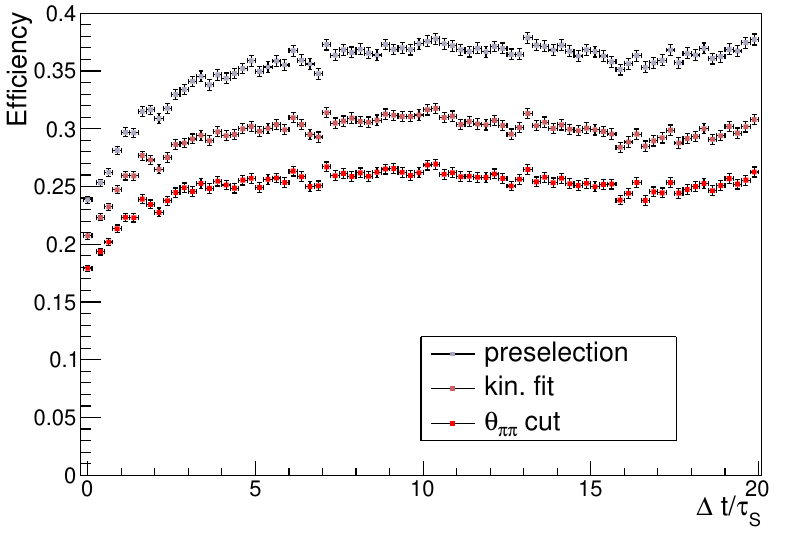
Figure 2 . Efficiency evaluated from the Monte Carlo, after the preselection criteria applied (grey), the kinematic fit (brown), and the cut on the θ angle (red). The vertical error bars indicate the ππ statistical uncertainty of the Monte Carlo sample.